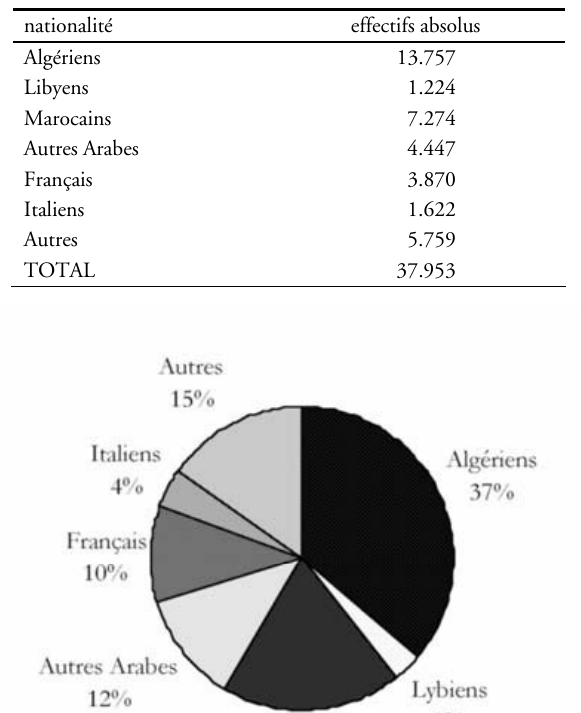
Présence étrangère en Tunisie par principales nationalités (effectifs absolus), 1994